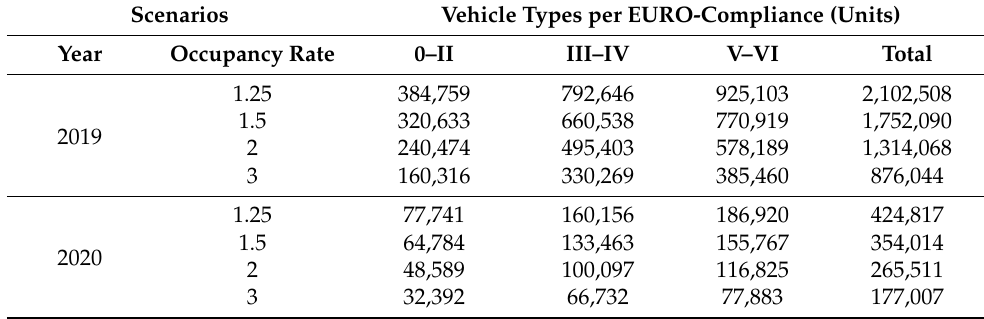
Table 4. Passenger car traffic scenarios according to EURO-compliance, 2019 and